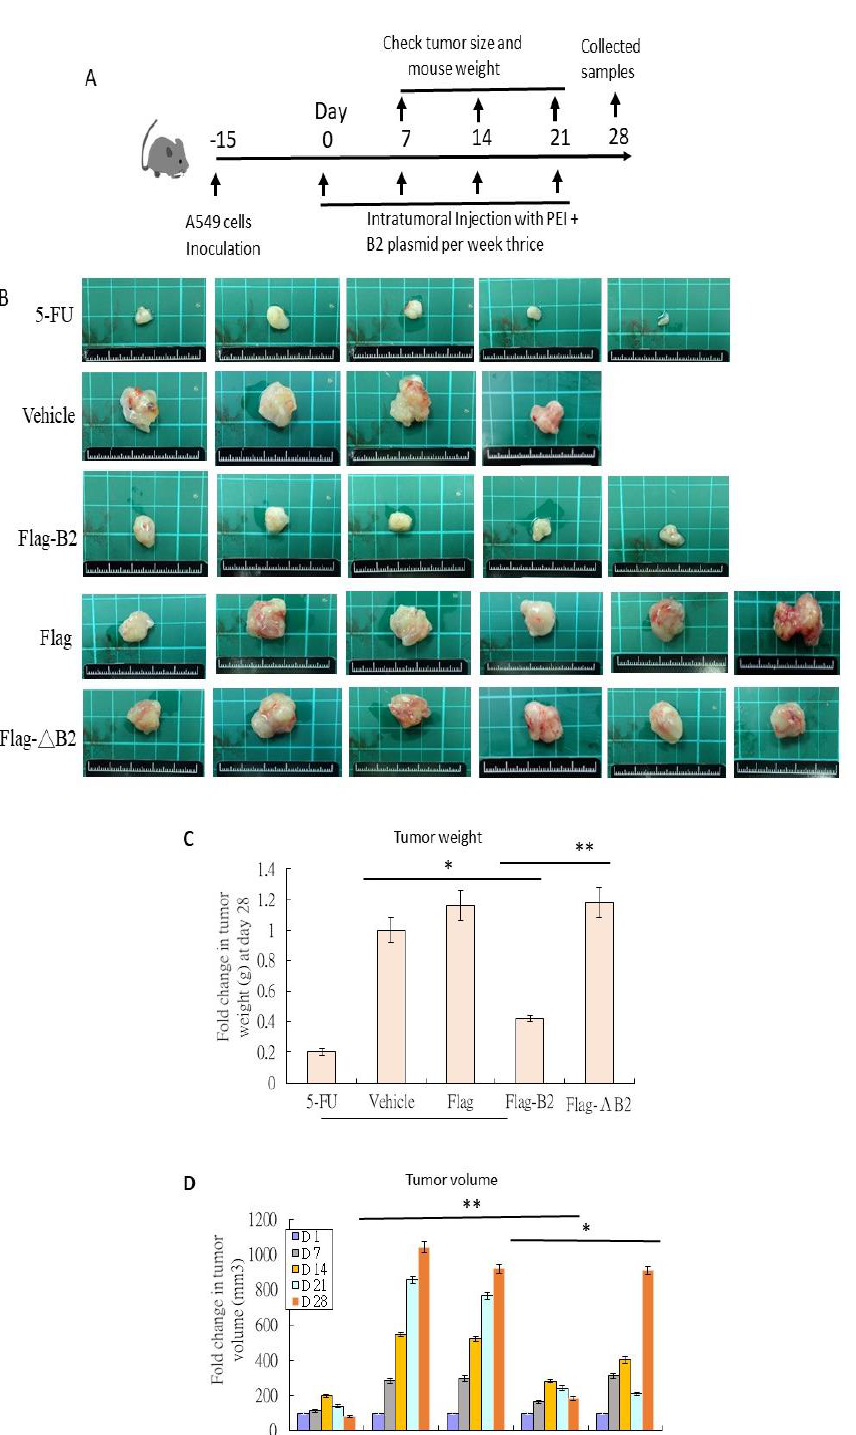
Figure 4. B2 protein can kill A549 lung cancer cells in an NOD/SCID mouse. ( A,B ) Tumor samples suggesting that B2 gene injections block cancer growth 28 days after 5-FU (positive control; N = 5), vehicle (negative control; N = 4), Flag-B2 ( N = 5), Flag ( N = 6), and Flag- ΔB2 (mutant control) treatments ( N = 6; see Table 1). Quantitative analysis of ( C ) tumor weight and ( D ) tumor volume of samples presented in Figure 3B. N = 4–6. The data are representative of three separate experiments, and the error bars represent the SEMs. The data were analyzed by one-way ANOVA with Tukey’s multiple comparison test, with p -values defined as * p < 0.05 and ** p < 0.01 compared to the control groups.